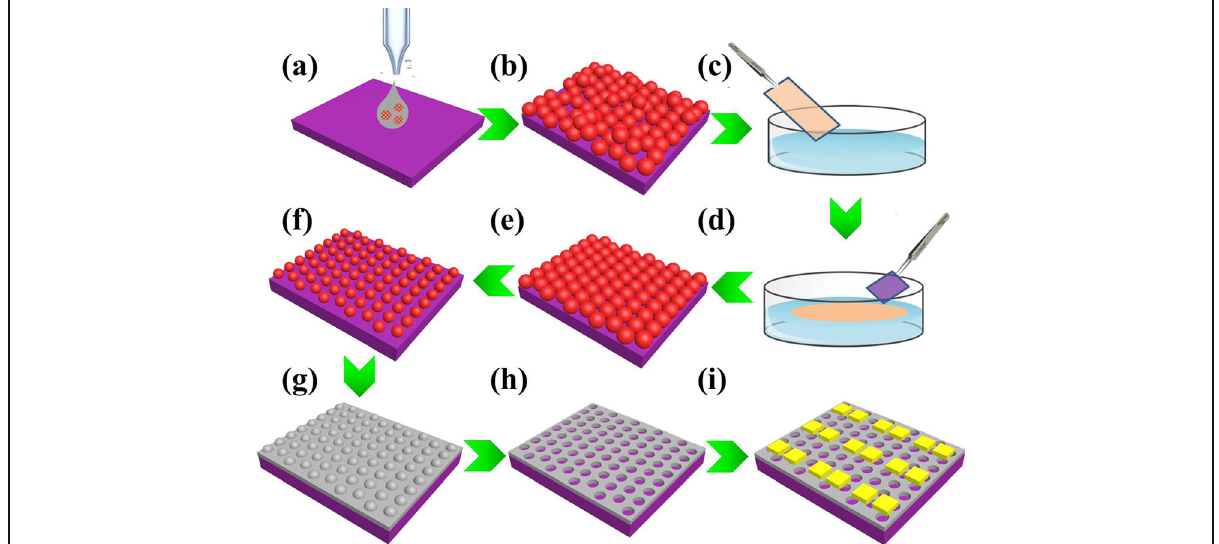
Fig. 1 Schematic illustration of the fabrication processes for cross-linked network based gas sensors. a Drop PS microspheres solution onto a 2 cm × 4 cm Si 3 N 4 substrate. b PS microspheres self-assemble into an irregular monolayer. c Insert the above Si 3 N 4 substrate into deionized water. d PS microspheres reassemble into a close-packed regular array floating at the air/water surface. e Another 1 cm × 1 cm Si 3 N 4 substrate was used to carefully pick up the two-dimensional array. f Plasma etching was executed to control the size of PS microspheres. g Deposit the SnO 2 /NiO thin film by sputtering technique. h Remove the PS microspheres to form a cross-linked SnO 2 /NiO network. i Deposit the gold electrodes